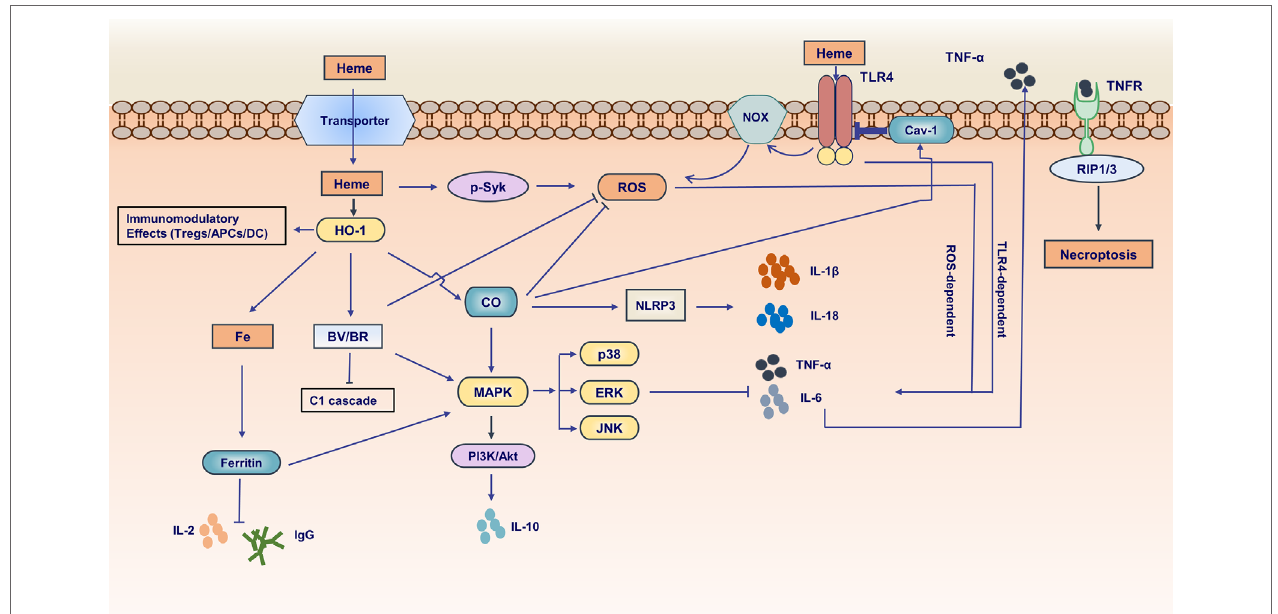
FIGURE 2 | Pivotal functions of the molecules in heme metabolic pathway in inflammation. Free heme is transported by an unknown transporter into intracellular side. Heme can activate spleen tyrosine kinase (Syk) and subsequently induce reactive oxygen species (ROS) generation. Furthermore, heme can activate Toll- like receptor4 (TLR4) inducing ROS production dependent on NADPH oxidase and promoting proinflammatory cytokines [e.g., tumor necrosis factor- α (TNF- α )] generation. HO-1 have immunomodulatory effects in dendritic cells (DCs), antigen-presenting cells (APCs) and regulatory T cells. In heme metabolic pathway, the end product ferrous iron (Fe 2+ ) is proinflammatory and could be sequestered by iron storage protein ferritin. The ferritin inhibits interleukin-2 (IL-2) and IgG production. In addition, it is involved in mitogen-activated protein kinase (MAPK) signaling pathway. CO downregulates the production of proinflammatory cytokines (e.g., TNF- α , IL-6) and upregulates the anti-proinflammatory cytokines (e.g., IL-10) relating to MAPK signaling pathway. CO inhibits ROS generation and regulates inflammasome activation followed by impacting IL-1 β maturation and secretion. Of note, CO could augment the interaction between caveolin-1 (cav-1) and TLR4 suppressing TLR4-mediated signaling. BV/BR exerts anti-inflammatory and anti-oxidant effects about innate and adaptive immunity. The production of pro- inflammatory cytokine TNF- α can be secreted into extracellular side. TNF- α binds to its receptor inducing necrosis mediated by receptor-interacting protein